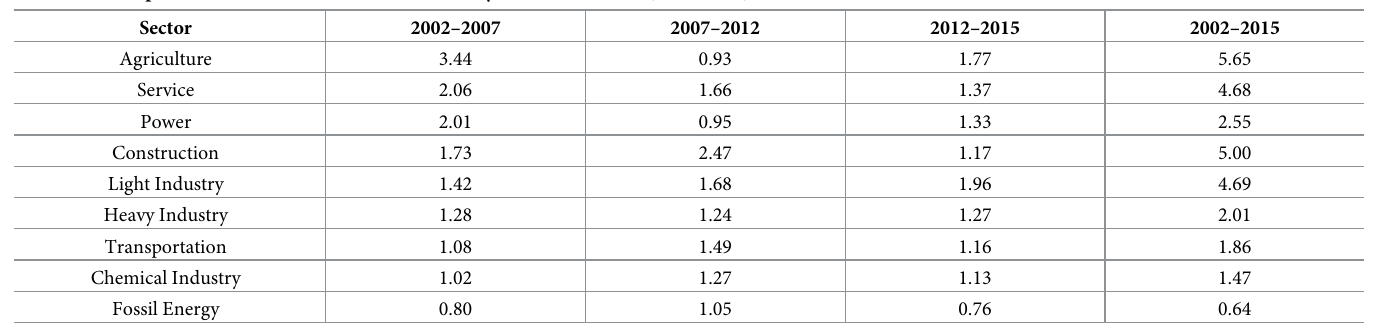
Table 11. The optimization of carbon emissions efficiency in various sectors